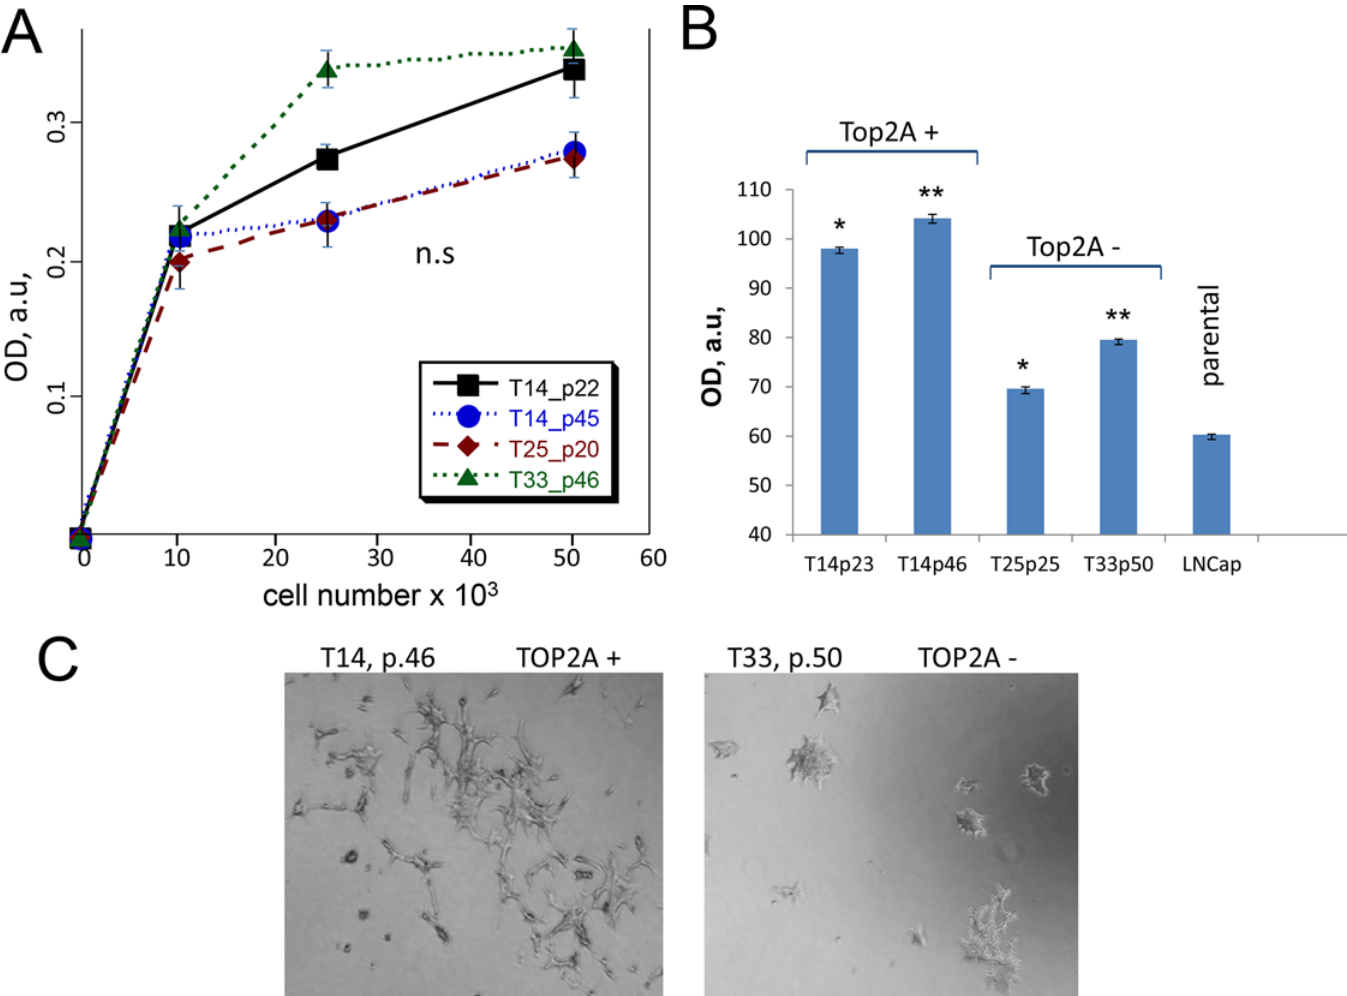
Fig 1. TOP2A promotes aggressive invasive phenotype. A) Proliferation of clones stably overexpressing TOP2A (T14) and matched control cells with endogenous level of TOP2A (T25 and T33). Proliferation was determined at 96 hours after cell plating. B) Motility of TOP2A clones of different passage and parental LNCaP cells determined using Boyden chamber assay. C) Images of cells with invasive phenotype after 72 hours of proliferation. P designates passage number; OD, au is measured optic density in arbitrary units. Data are presented as mean ± SD, based on 3 independent experiments. * p < 0.00001, and ** p < 0.0001, n =